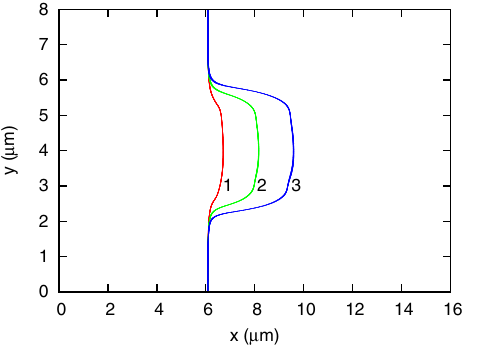
FIG. 4. The angular distribution of accelerated protons versus the transversal position y .